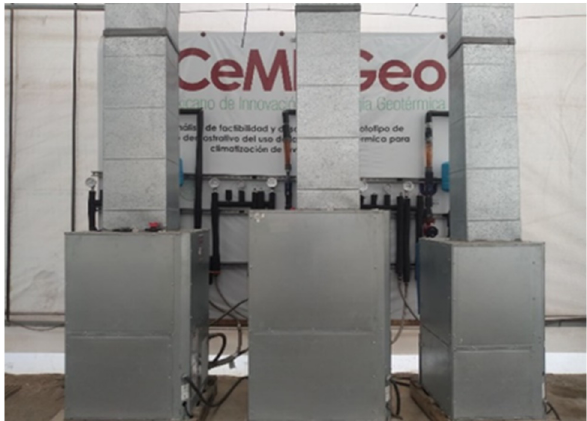
Figure 7. Geothermal heat pump systems were installed at the study